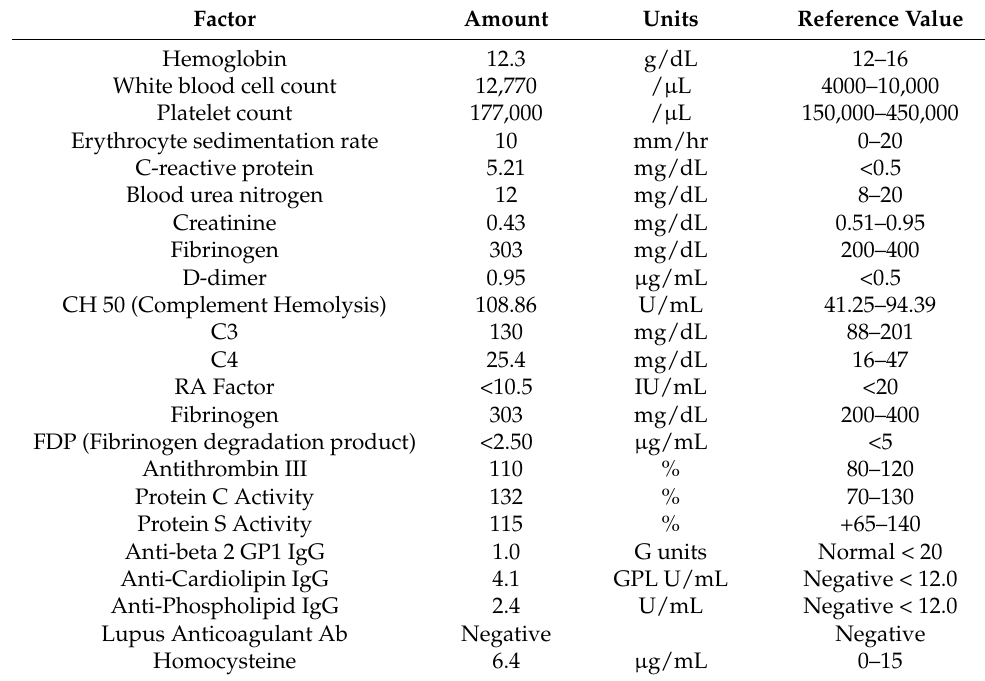
Table 1. Laboratory findings of the